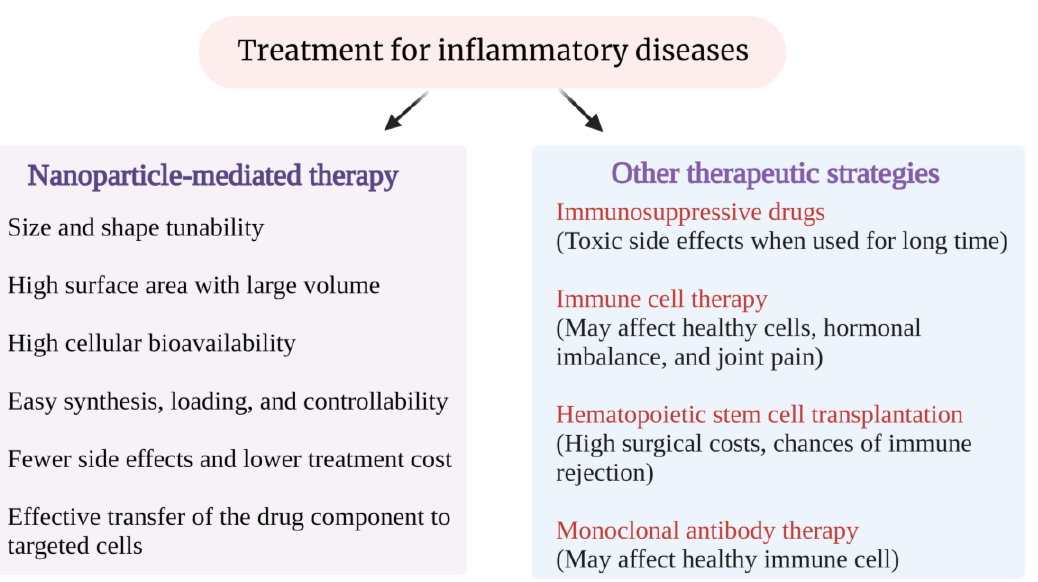
Figure 1. The advantages of NP-mediated therapeutic technologies to treat inflammatory diseases.